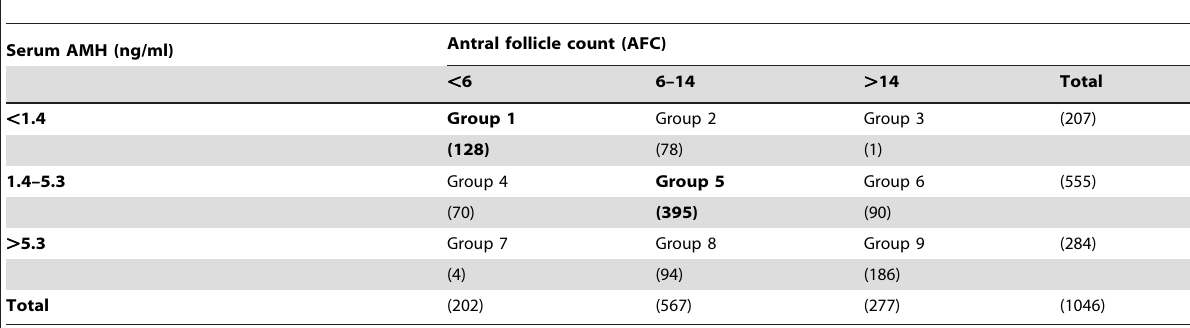
Table 1. Grouping of subjects according to the quartile of serum AMH and AFC values.